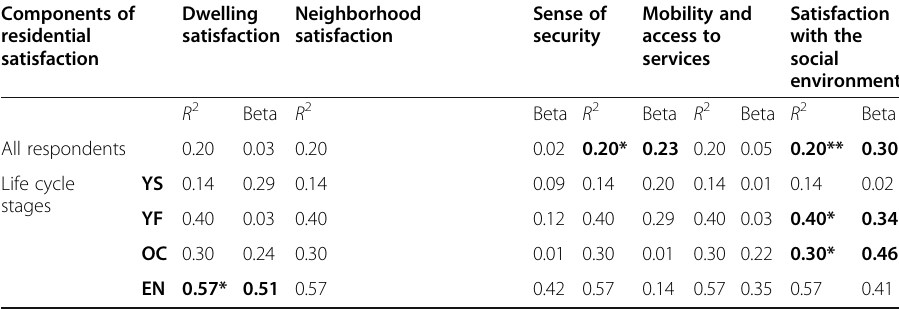
Table 16 Regression analysis results for ‘ overall residential satisfaction ’ Components of residential